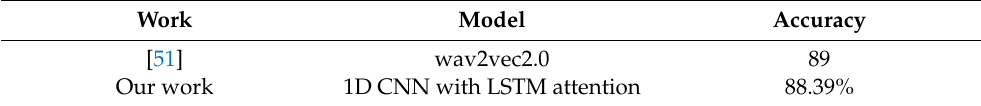
Table 9. Performance comparison of the works in the BAVED